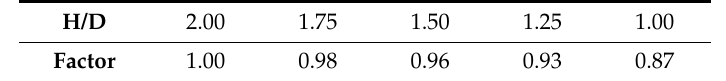
Table 4. Correction factors for cylindrical samples under uniaxial compression with height to diameter ratio less than 2 (i.e., H/D < 2) (ASTM Standard C39/C39M 2012) [45].